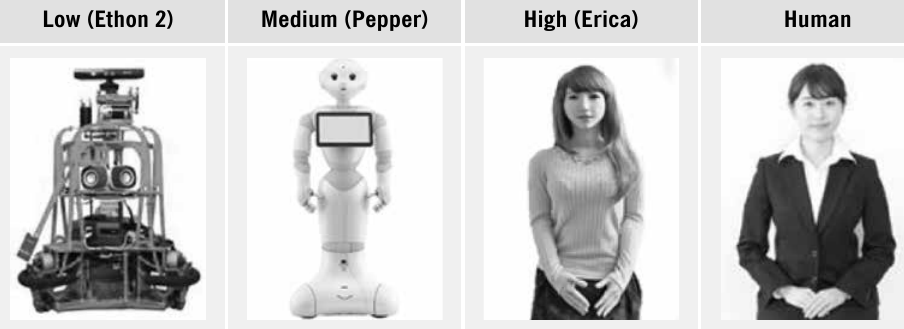
Table 1. Stimuli of the anthropomorphism manipulation conditions Low (Ethon 2) Medium (Pepper) High (Erica)